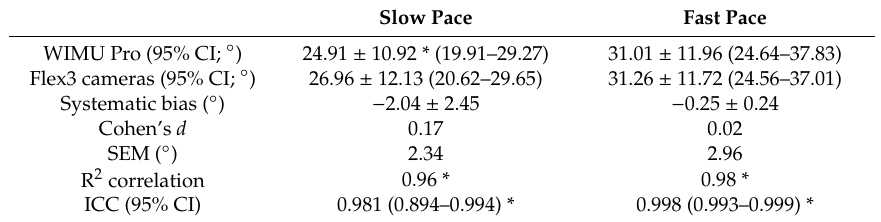
Table 1. Concurrent validity of WIMU Pro device relative to the MOCAP system when used to monitor range of motion during fast- and slow-paced